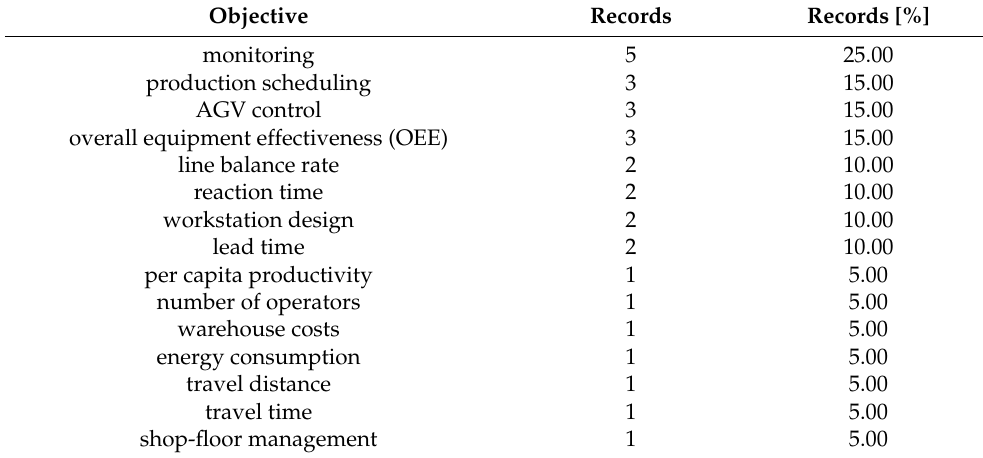
Table 11. Targeted objectives.